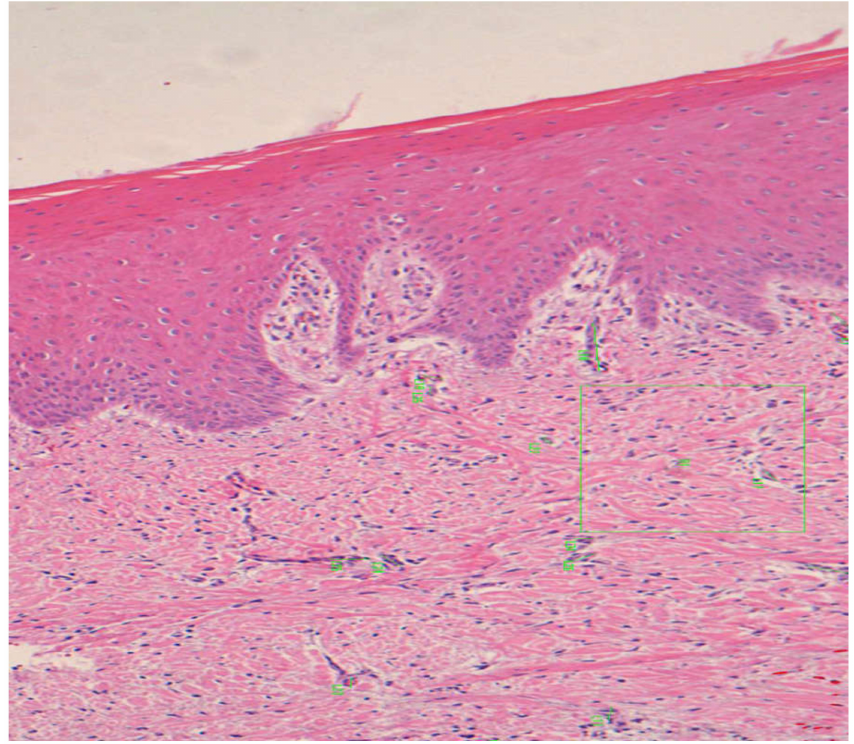
Figure 4. Detail of mADMG ® biopsy at 45 days showing the marking (green) of the vessels for measurement and counting (100 ×